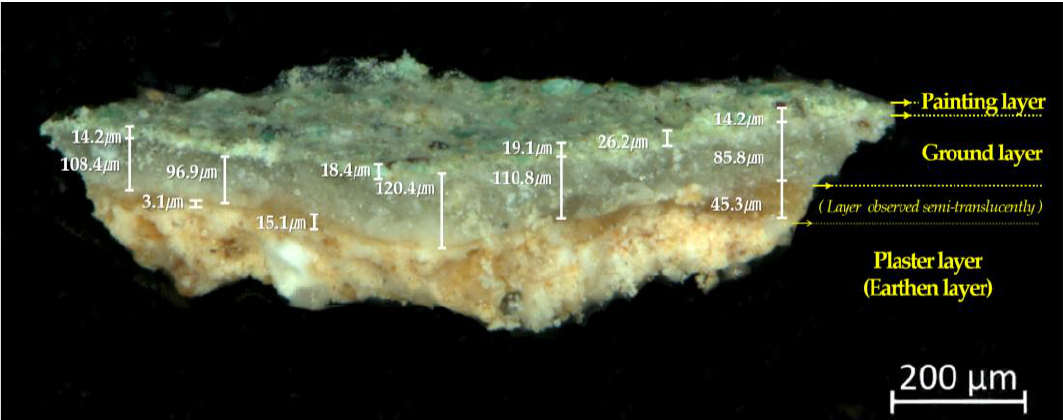
Figure 5. Optical image of a part of mural sample.